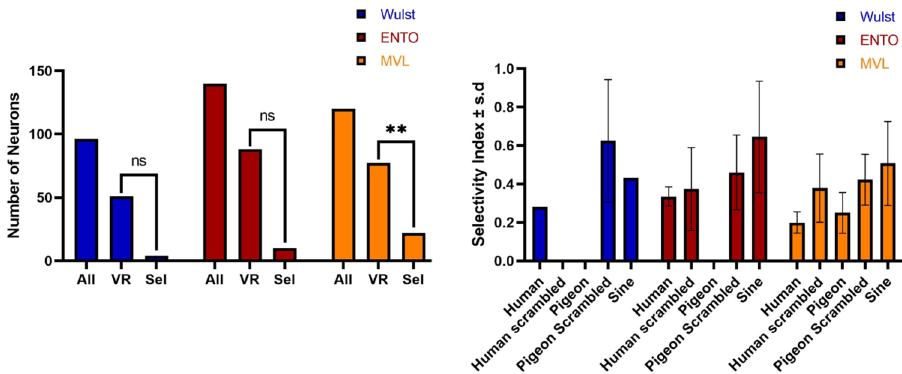
Figure 4. Stimulus selectivity of Wulst, ENTO, and MVL neurons. Comparisons between the three regions (left) of the total numbers of isolated neurons (All), visually-responsive neurons (VR), and stimulus-selective neurons (Sel): ** p < 0.01. Average SI for stimulus-selective neurons in Wulst, ENTO and MVL (right). SI values reflect the degree to which a given group of neurons is selective for their preferred stimulus grouping. Greater SI values indicate larger differences between the average responses to the preferred stimulus grouping of a given neuron versus the averages of the other four stimulus